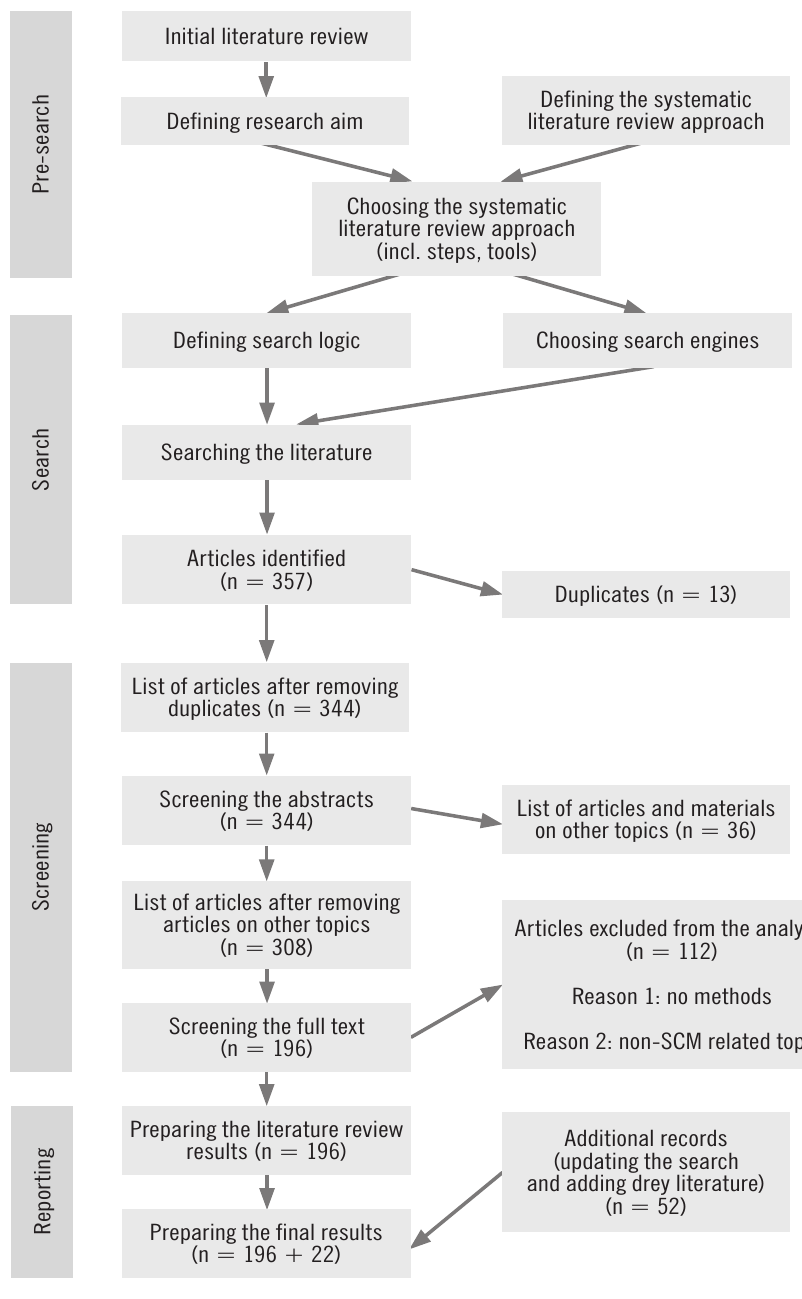
Figure 1. Systematic literature search and review